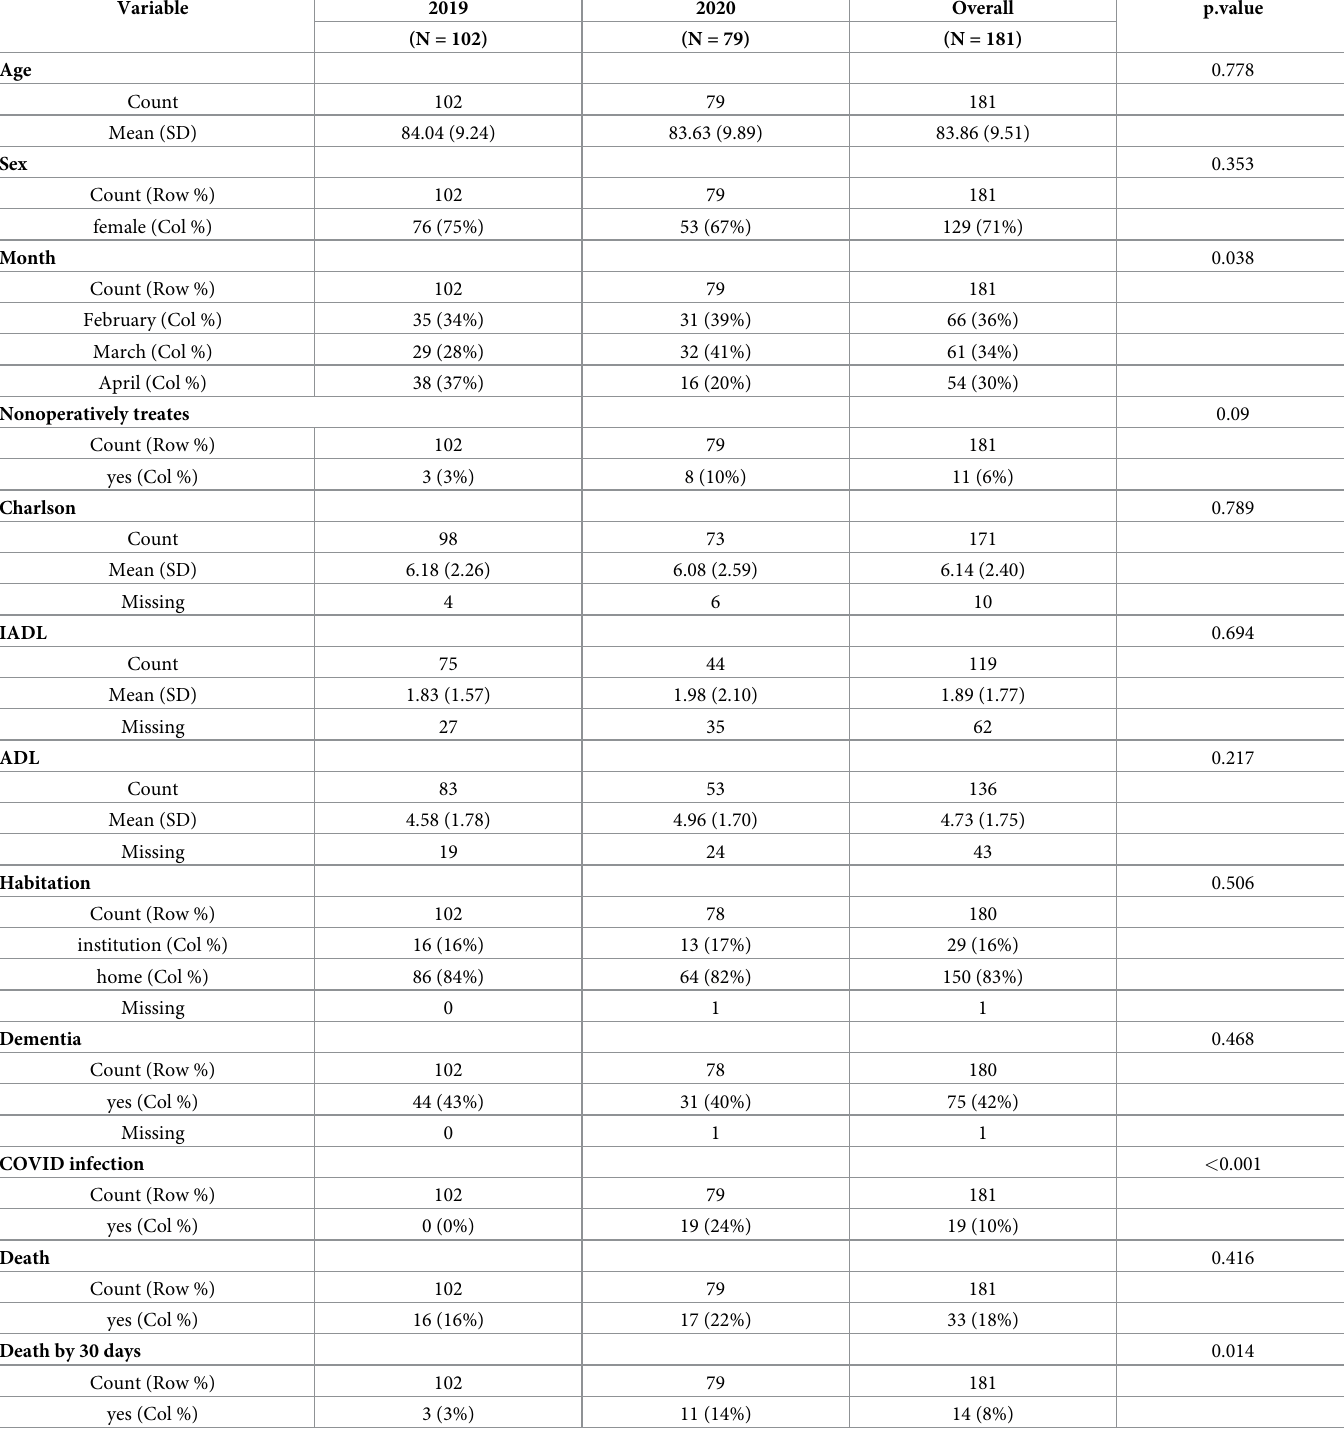
Table 1. Demographic and medical characteristic of the